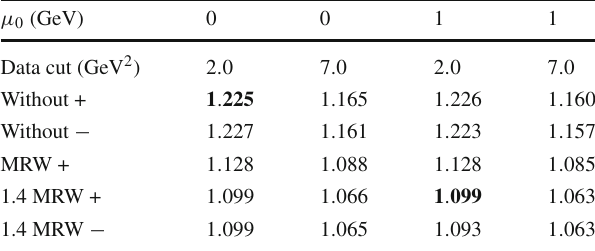
Table 1 The quality of the fits in terms of reduced χ 2 by degrees of freedom,thatis χ 2 /